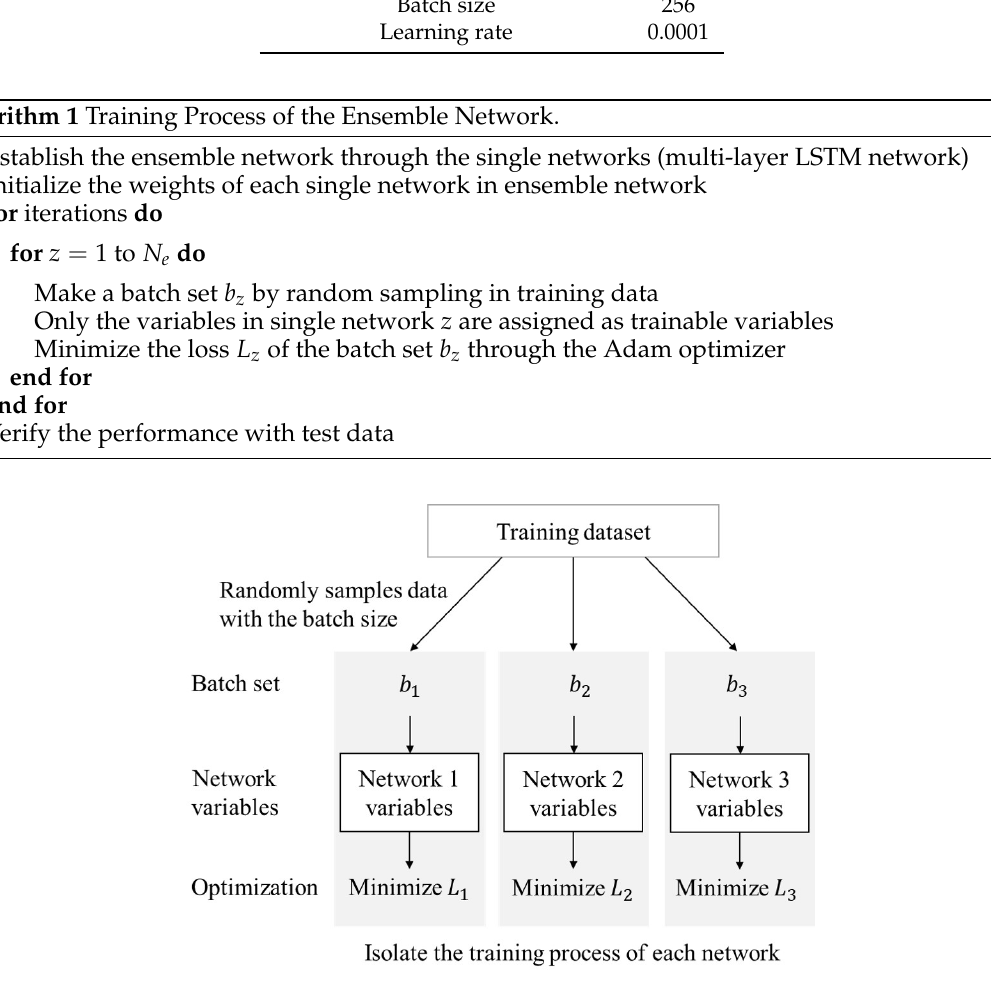
Figure 4. Multiple network learning process for the ensemble